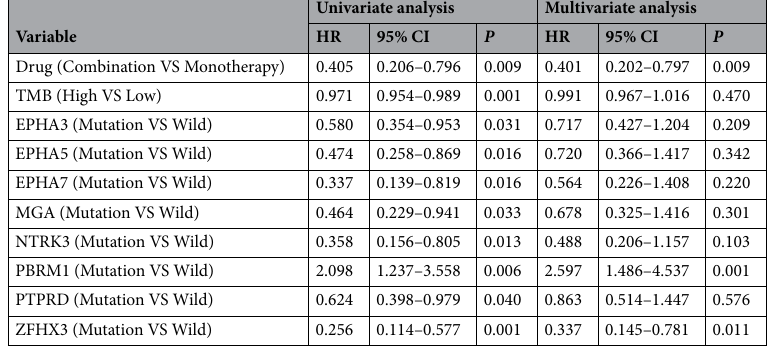
Table 2. Prognostic value of clinical factors and the gene mutation with overall survival in NSCLC treated with ICB. Monotherapy: anti-PD-(L)1 monotherapy; Combination: anti-PD-(L)1 monotherapy in combination with anti-CTLA-4; TMB high: TMB ≥ 10; TMB low: TMB <